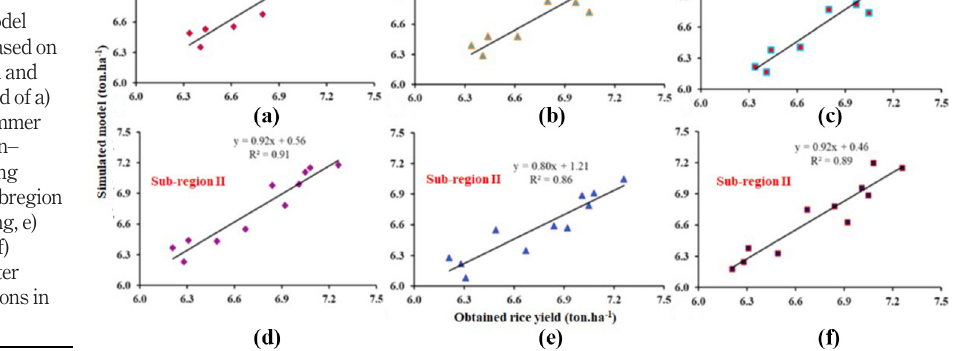
Figure 3. Results of model